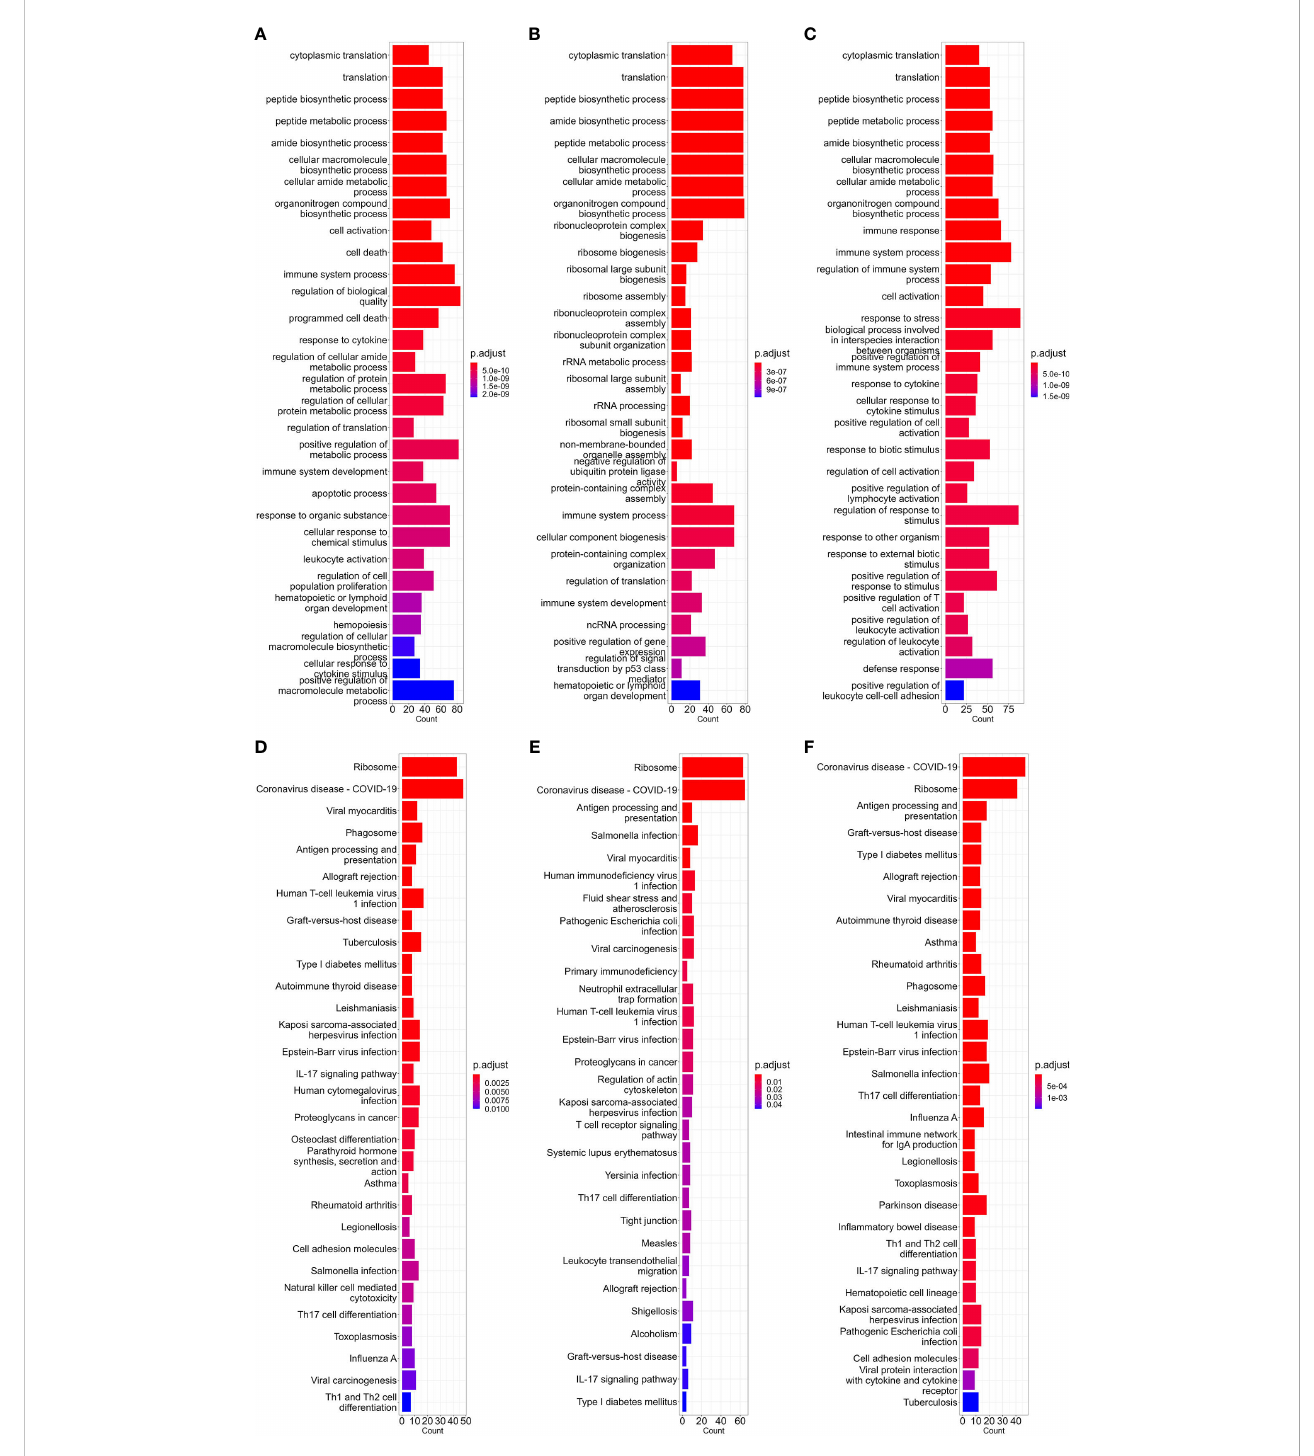
FIGURE 1 Barplot of GO-BP (A – C) and KEGG (D – F) enrichment analysis results of bloodmonocytes (A, D) , CD4+ Tfh (B, E) in bulk RNA-seq datasets and dendritic cells (C, F) in lung scRNA-seq datasets. For each analysis, the top 30 enriched pathways according to p-value are